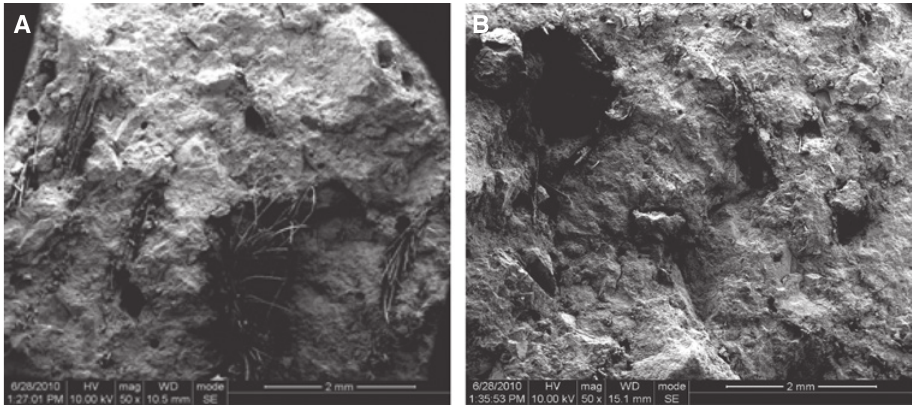
Figure 2: SEM photos of the dispersion of PVA fibers in cement mortar: (A) untreated fibers; (B) treated fibers.